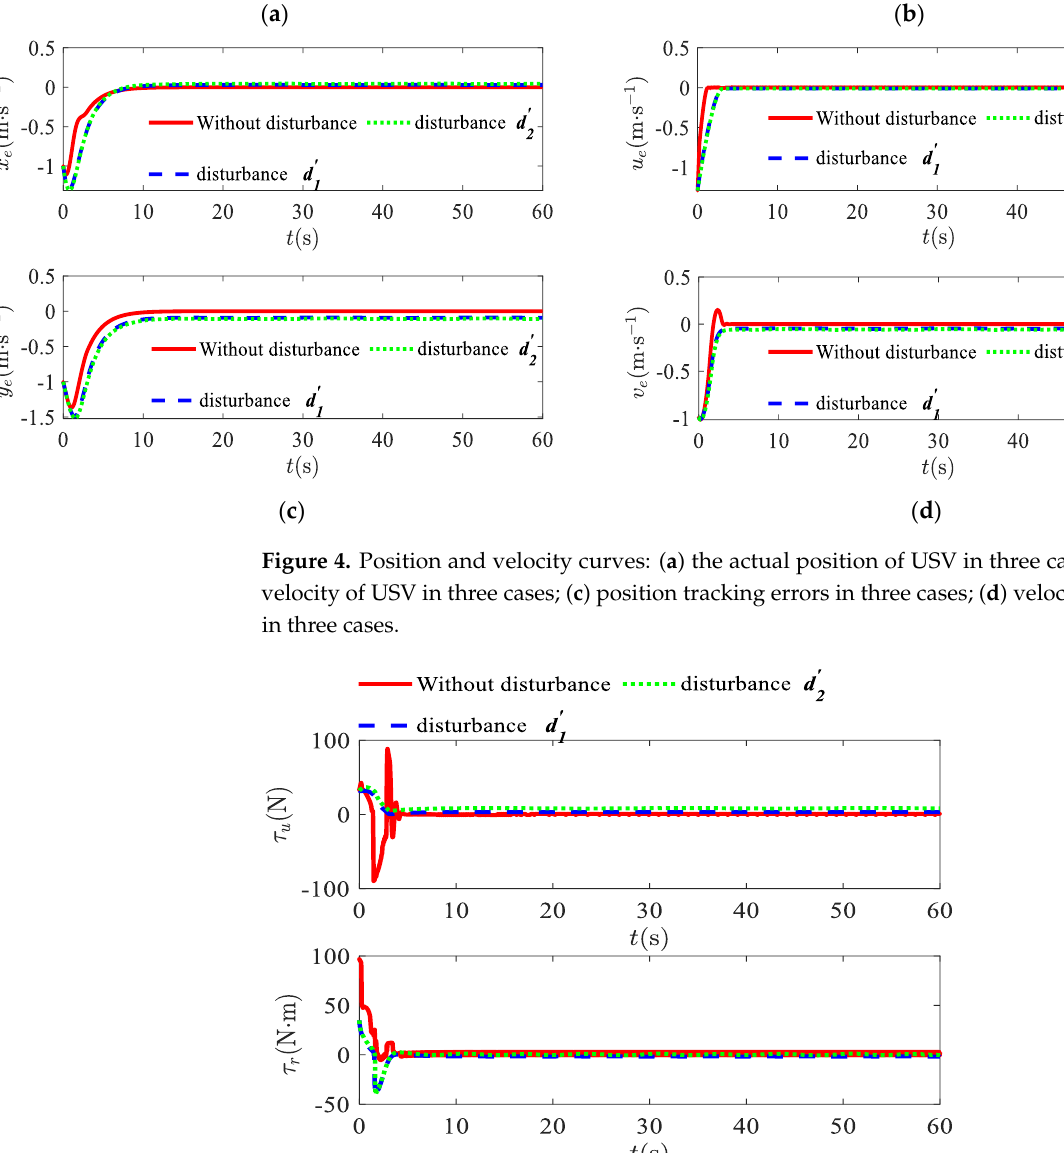
Figure 5. Surge force and yaw moment in three cases.